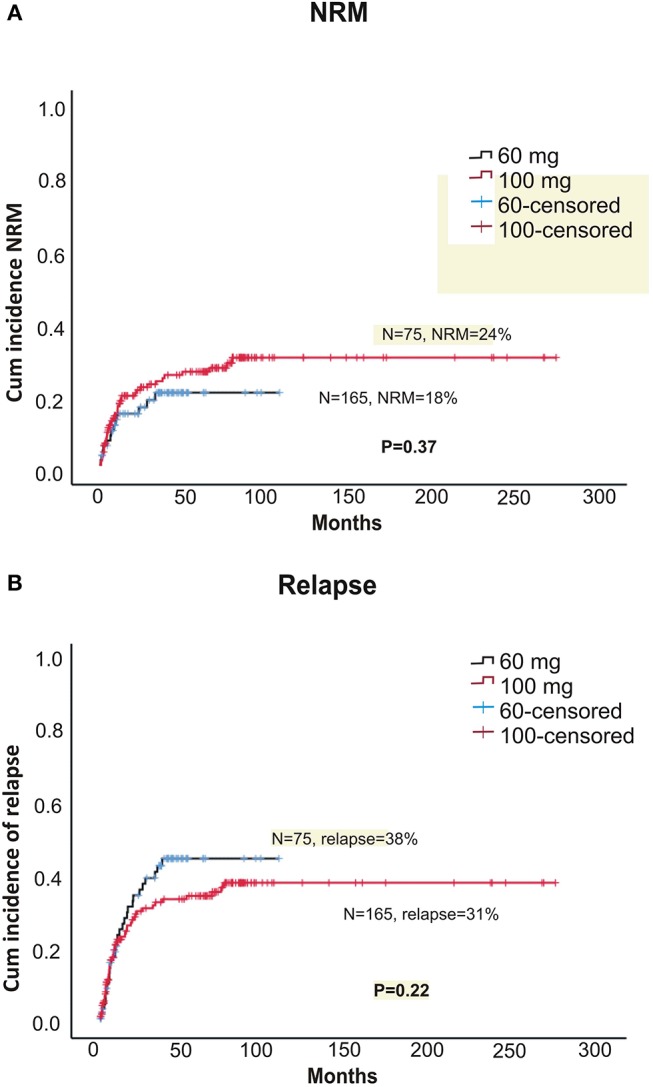
(A) Cumulative incidence of non-relapse treatment-related mortality (NRM) between two doses of alemtuzumab. (B) Cumulative incidence of relapse between two doses of alemtuzumab.